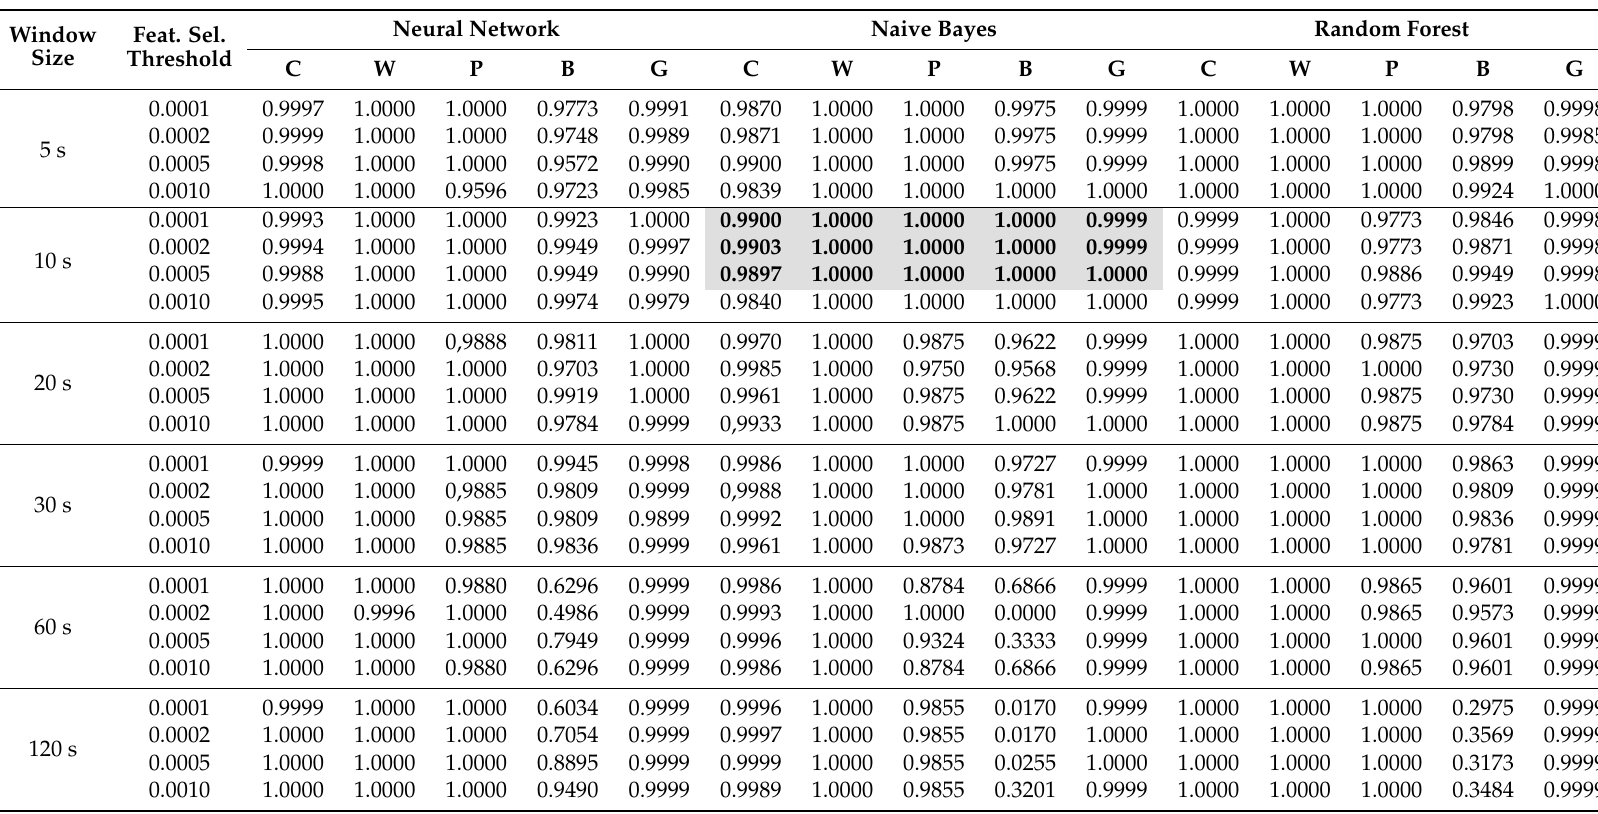
Table 7. Classification accuracy of each model for different configurations of hyper-parameters and ransomware. C: Clean, W: WannaCry, P: Petya, B:BadRabbit, G: